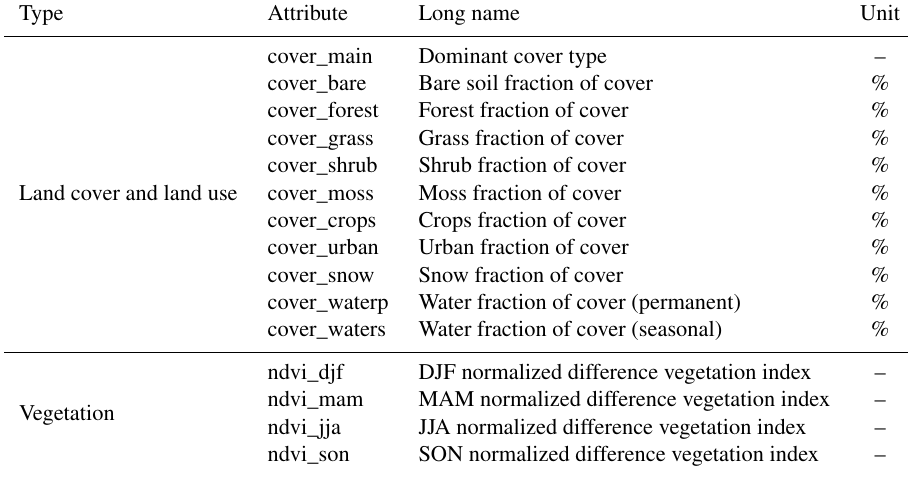
Table 8. Land-cover attributes of CABra catchments.